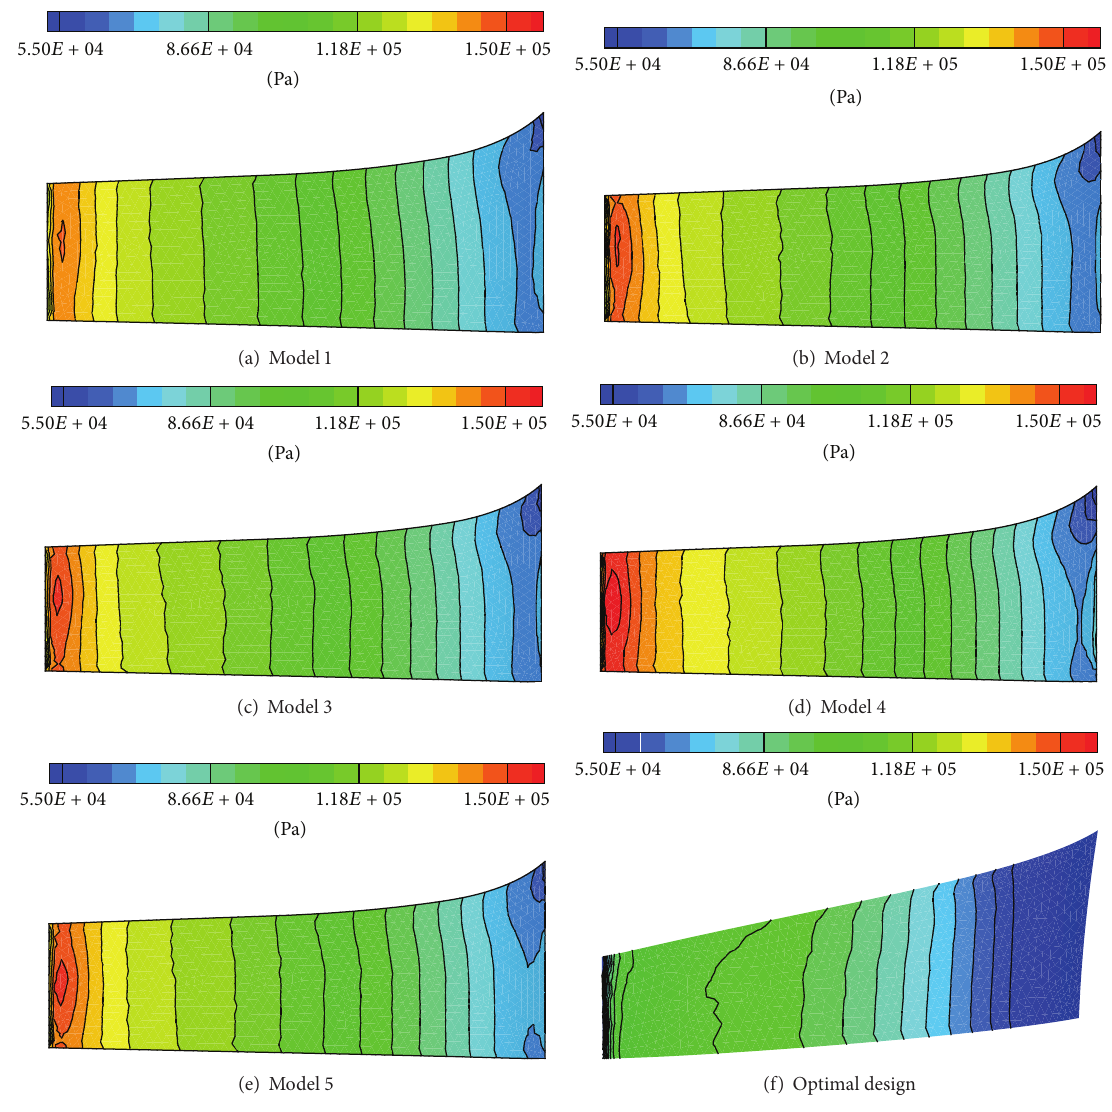
Figure 11: Static pressure distribution on blade’s pressure